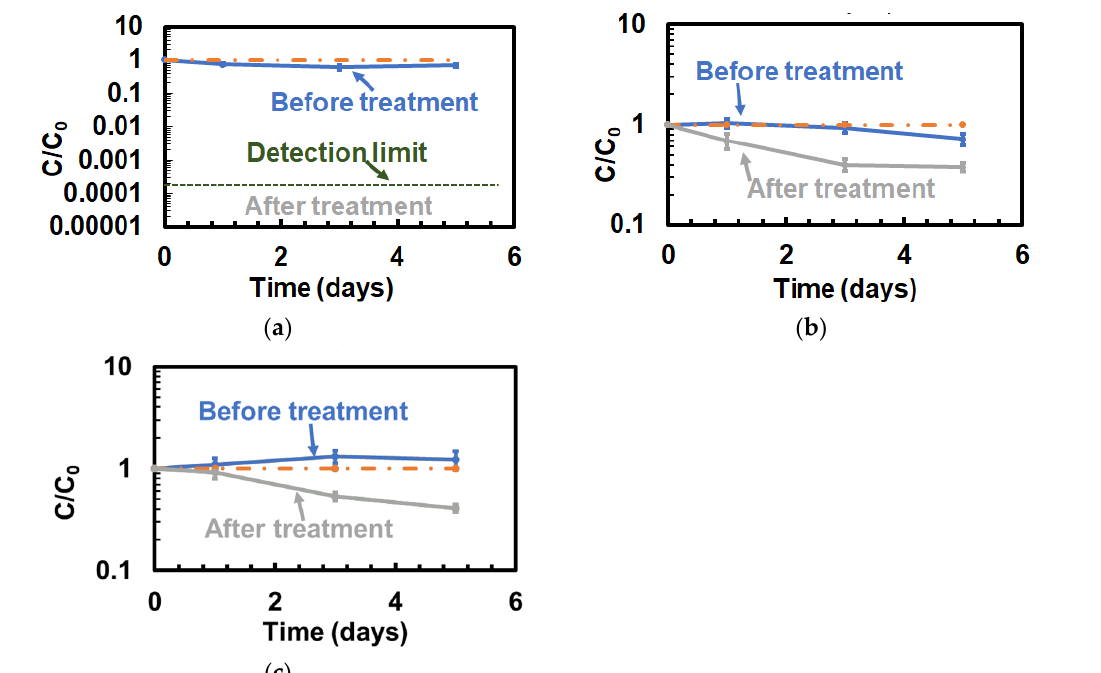
Figure 4. Dark repair experimentation plots indicating the concentration of E. coli in water vs. time for water stored in the dark following treatment using the following conditions: ( a ) photocatalysis using porous TiO 2 nanowires, ( b ) exposure to nanowires that are not excited with UV light (dark control) and ( c ) exposure to UV light in the absence of photocatalysts (clear control). In all the plots, “before treatment” indicates the concentration of E. coli in water samples that did not undergo any treatment, but aged in a similar manner as the treated samples.